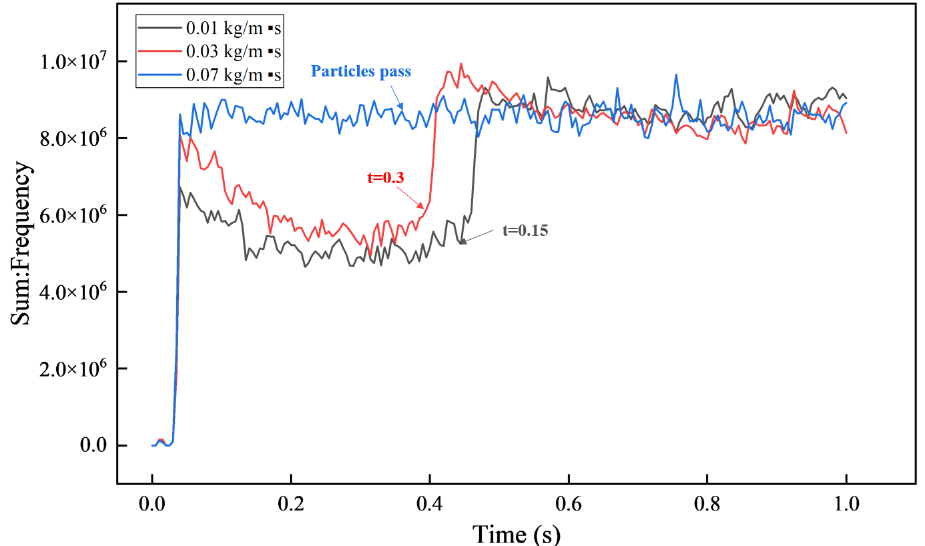
Figure 22. Flow properties of 1.5 mm LCMs under the action of drilling fluids with different viscos- ities.